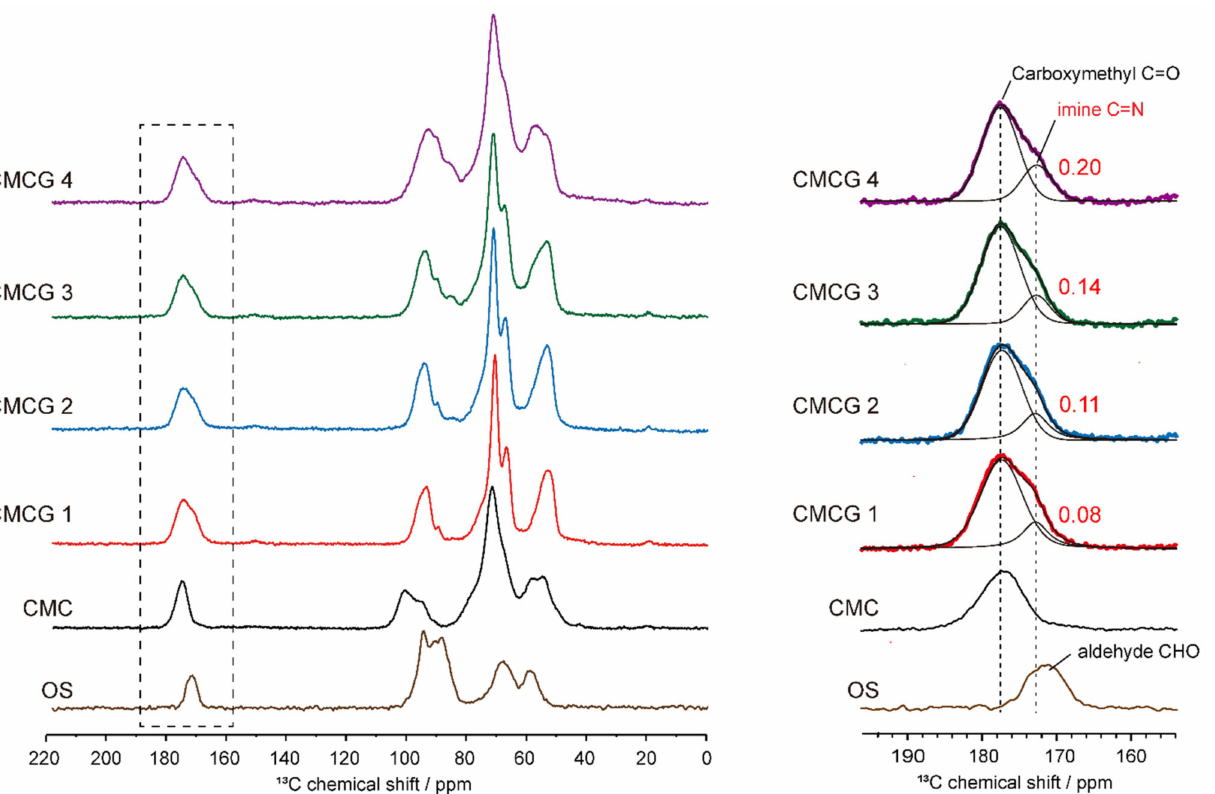
Figure 7. Quantitative solid-state 13 C NMR spectra of CMCG 1–4, CMC, and OS (left-hand spectra), and the results of lineshape analysis for the carbonyl carbon region (right-hand